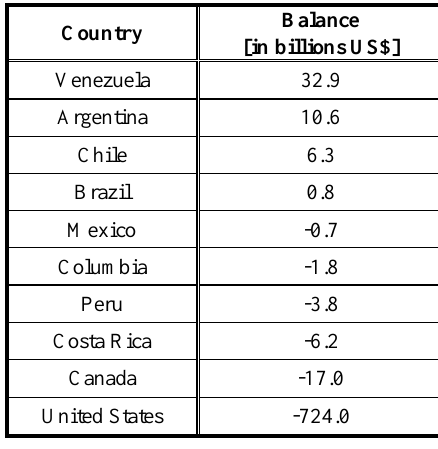
Figure 1. Imports vs. Exports Balance of Trade The balance of trade for each of the NAFTA countries was negative, ranging from -724.0B for the U.S. to -0.7B for Mexico. Among the Latin American countries, Venezuela had the highest balance of trade at +$32.9B and Costa Rica had the lowest at -$6.2B. Table 4 presents a listing of all included countries ranked by decreasing 2014 balance of trade in billions of U.S. dollars. Table 4: 2014 Balance of Trades by